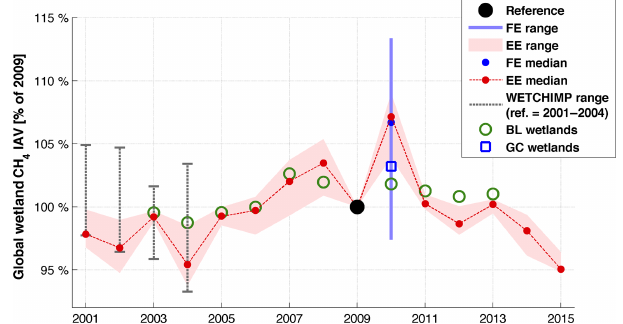
Figure 5. The global wetland CH 4 emission inter-annual variability range of the FE (2009–2010) and EE (2001–2015) emission models, normalized relative to 2009 emissions; the WETCHIMP (Melton et al., 2013) model ensemble inter-annual variability is normalized relative to 2001–2004 mean emissions.